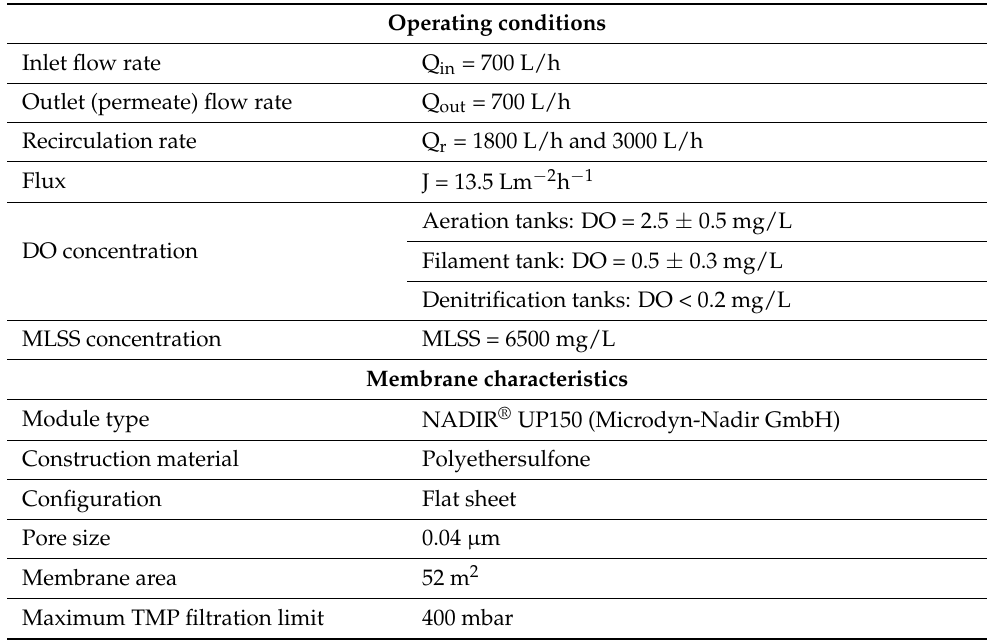
Table 1. Applied operating conditions and membrane characteristics in